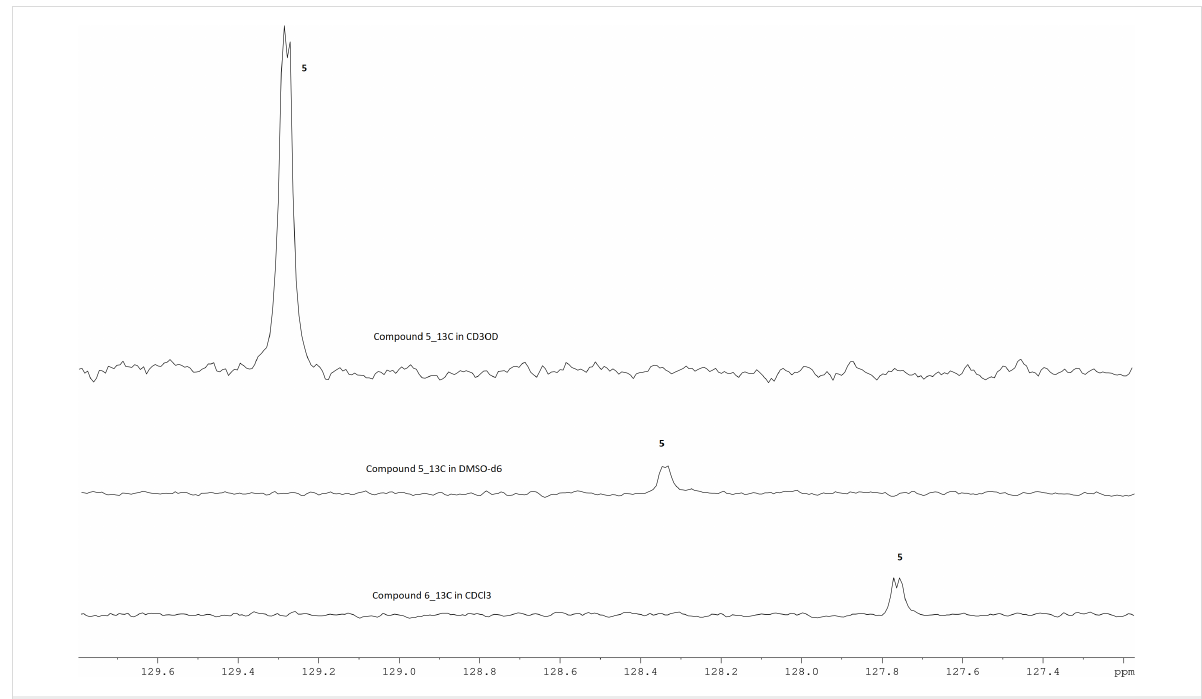
Figure 2: 13 C NMR spectra for coumarin 5 and 6 ; showing the splitting of the signal corresponding to C5.